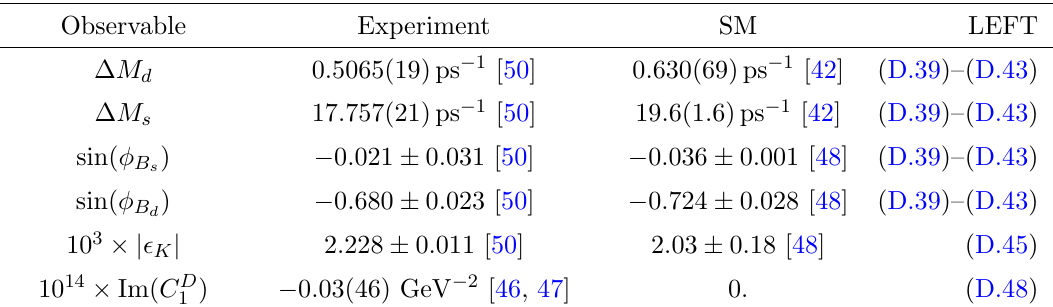
Table 12 . List of observables involving hadronic